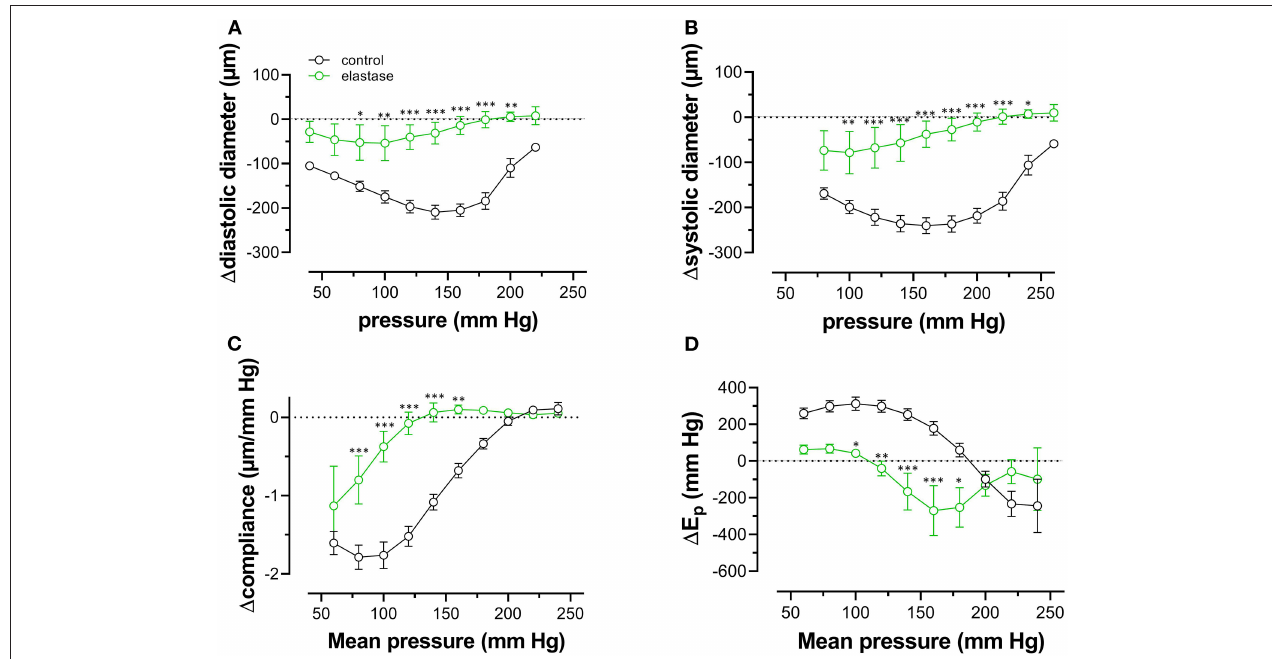
FIGURE 9 | Diastolic and systolic diameters, compliance, and stiffness in the presence of PE are elastin dependent. Diastolic diameter (A) , systolic diameter (B) , compliance (C) , and Peterson modulus, E p (D) , were measured in aortic segments in the presence of 2 µ M PE and 300- µ M L-NAME in control conditions (black symbols) or after treatment with 0.1 unit/ml elastase (green symbols). Two-way RM ANOVA with Sidak’s multiple comparison test (elastase vs. control), * p < 0.05, ** p < 0.01, *** p < 0.001, n =